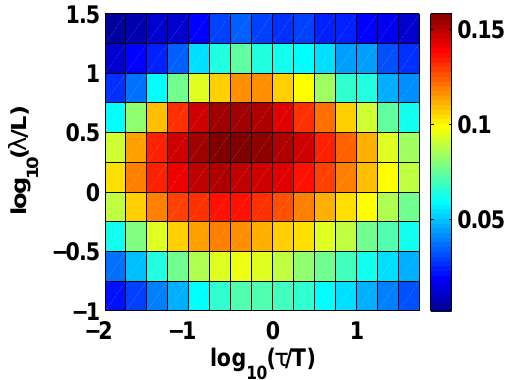
Fig. 4. Mean phytoplankton patch size h B s i× 10 − 5 km 2 as a func- tion of time and length scales ( τ,λ ) of the Gaussian flow, Eqs. (2– 4). Optimal Eulerian time and length scales are approximately ( log 10 τ c , log 10 λ c ) = ( − 0 . 5 , 0 . 875 ) . Each data point shown in the figure has been calculated as an average over 30 different initial conditions for the flow. Set of parameters as in Fig. 3.